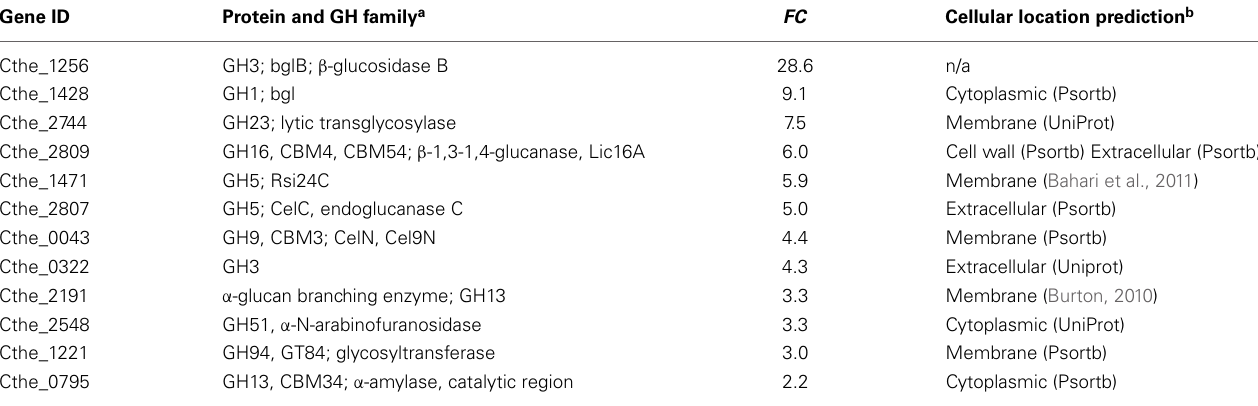
Table 3 | Twelve non-cellulosomal GH genes that were up-regulated by two or more folds in pretreated yellow poplar (PYP)- compared with cellobiose-grown C. thermocellum